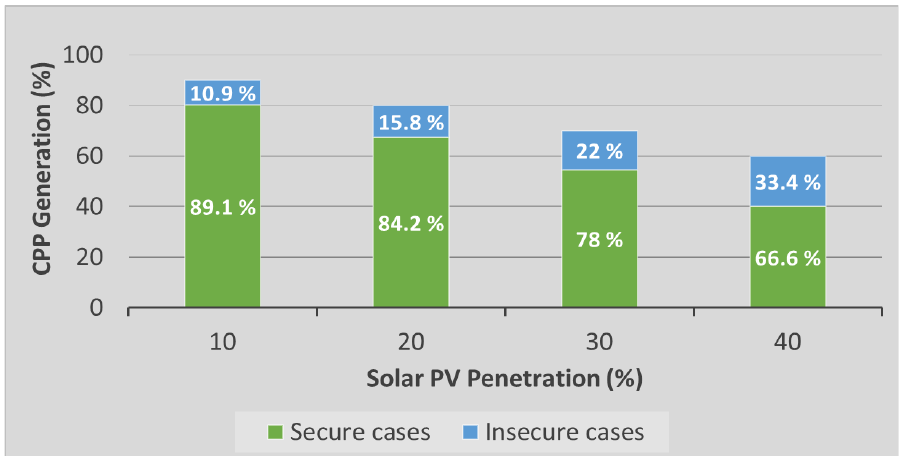
Figure 6. Summary of dynamic voltage security analysis for different PV penetration levels.